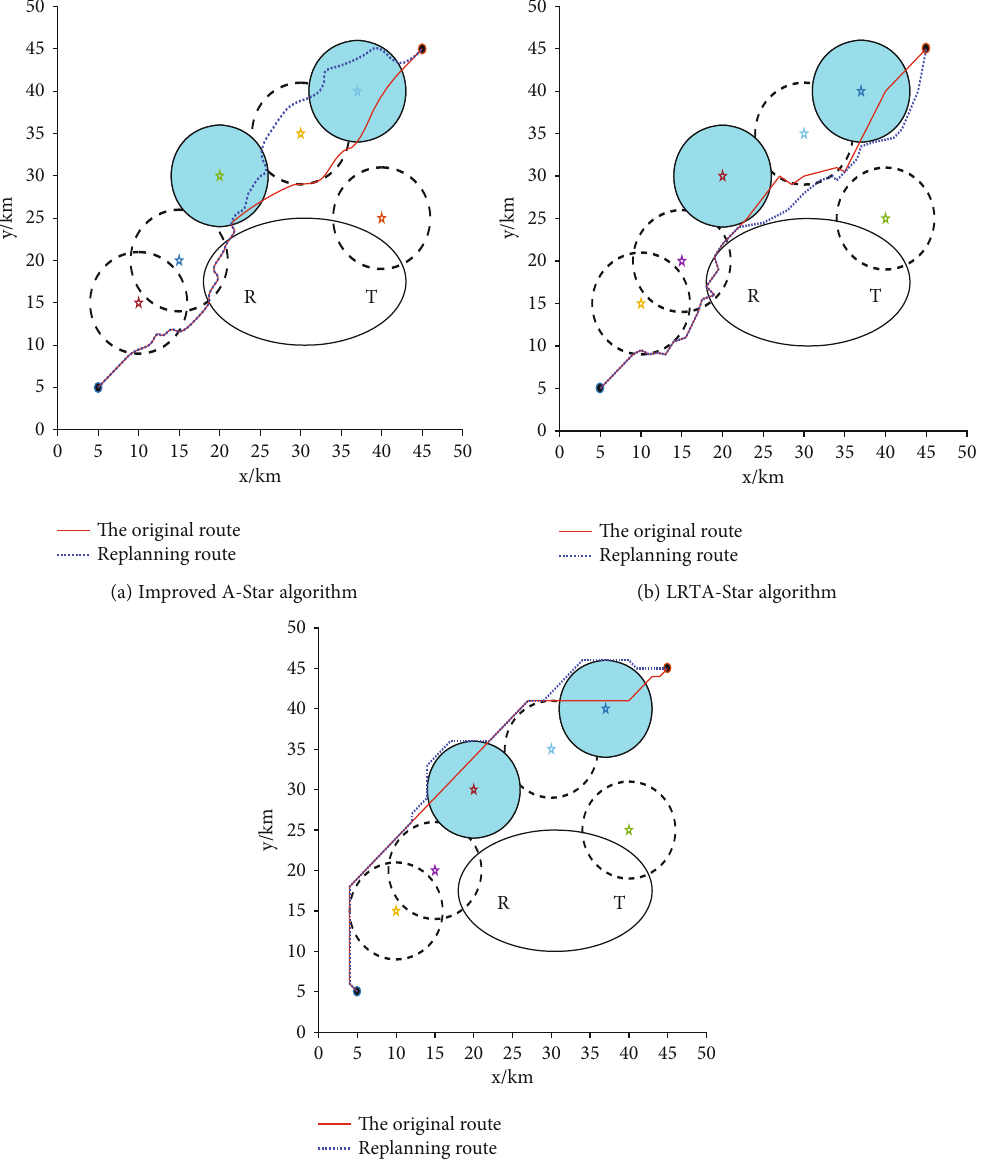
Figure 8: Numerical results of penetration path planning in the second